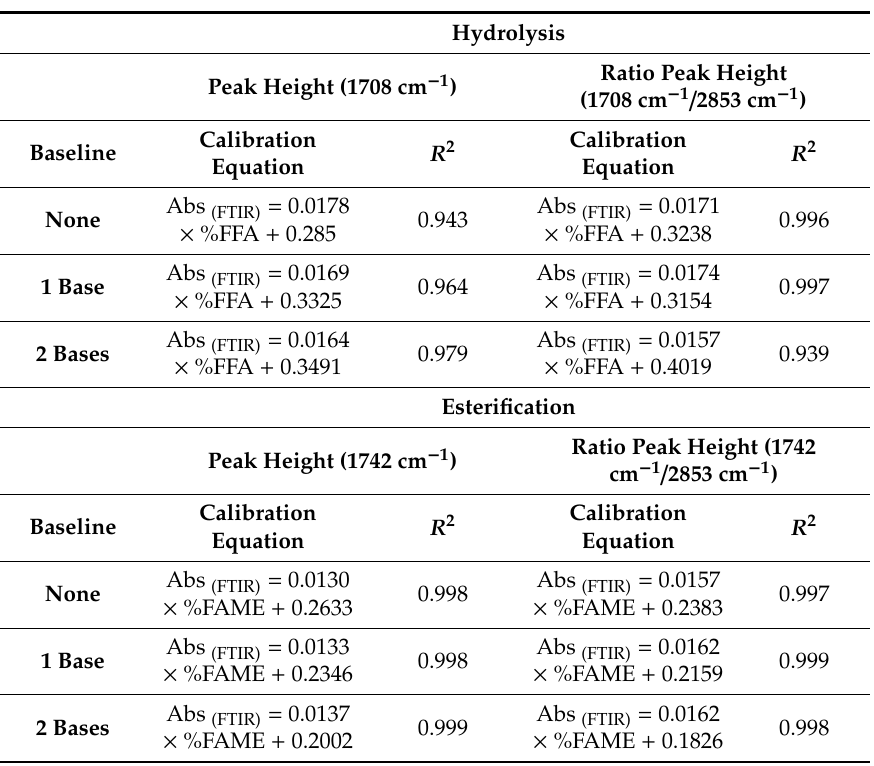
Figure 4. FTIR spectrum of the 1900–1600 cm − 1 region during olive pomace oil hydroesterification. ( A ) Hydrolysis reaction (range of ~46–74 wt.% FFA); ( B ) Esterification reaction (range of ~10–80 wt.% FAME). Table 2. Linear equations for monitoring hydroesterification (hydrolysis and esterification) of olive pomace oil by